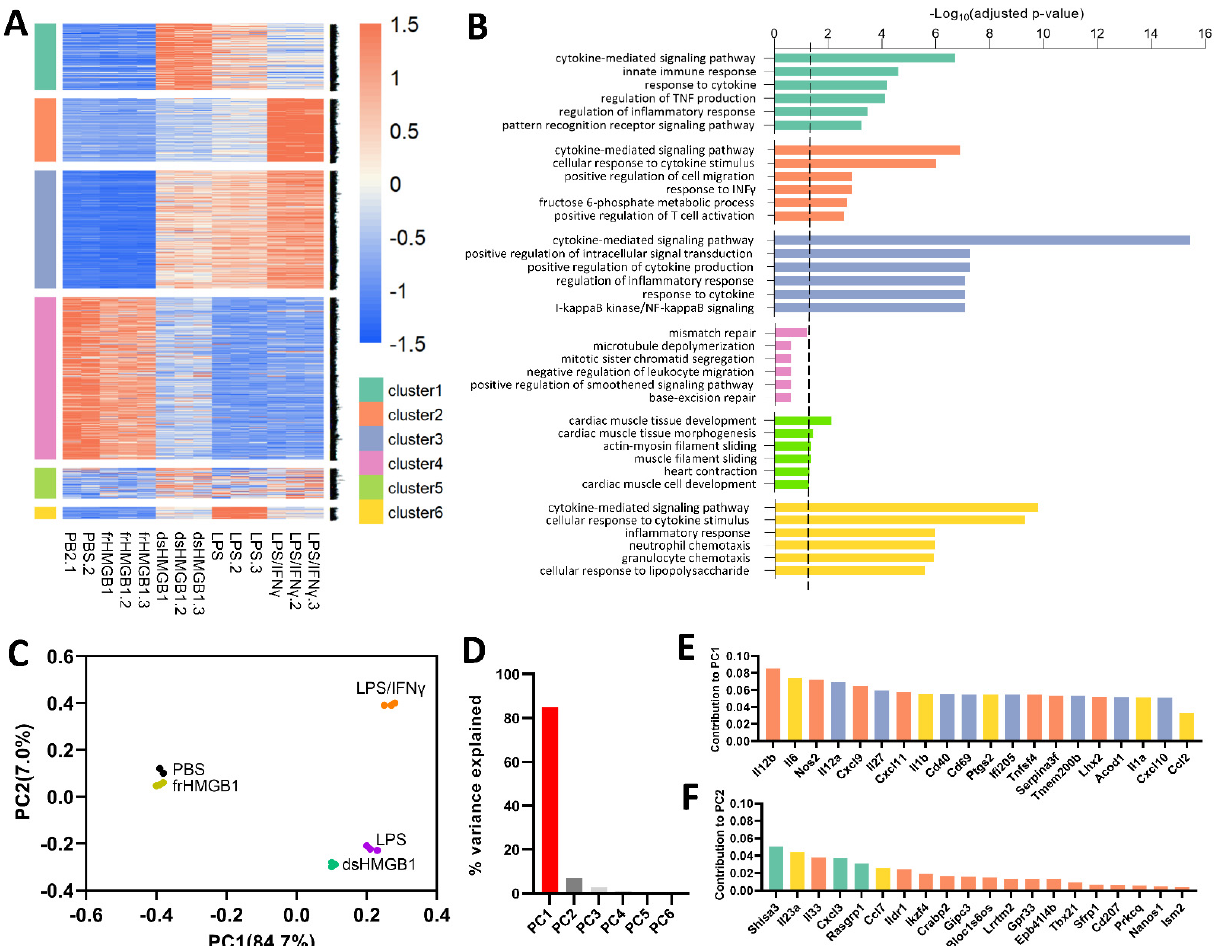
Figure 1. The general overview of transcriptome patterns of BMDMs stimulated 24 h with frHMGB1, dsHMGB1, LPS and LPS/IFN γ . ( A ) Clustered heatmap of normalized counts of 3952 differentially expressed genes. ( B ) Functional annotation of genes in each cluster was condcuted based on Gene Ontology (GO) enrichment. Only the top six enriched gene sets are presented, sorted by adjusted p -value. The scatter line indicates the cut-off p -value 0.05. ( C ) Principal component analysis (PCA) plot of the samples. ( D ) Percentage of variance explained by principal component (PC) 1 to 6. Only PC1 explained more than 80%; the other PCs were less abundant than PC1; especially none of PC2 to PC6 excessed 10%. ( E , F ) Ranking of the top 20 leading genes that contribute to the variance in PC1 and PC2. The colour of the bars of each gene corresponds to the colours of clusters specified in ( A ). Clusters 1, 2, and 6 represent the genes expressed highest in the dsHMGB1, LPS, and LPS/IFN γ groups, respectively; cluster 3 involves the genes generally higher expressed in dsHMGB1, LPS, and LPS/IFN γ groups compared with the PBS and frHMGB1